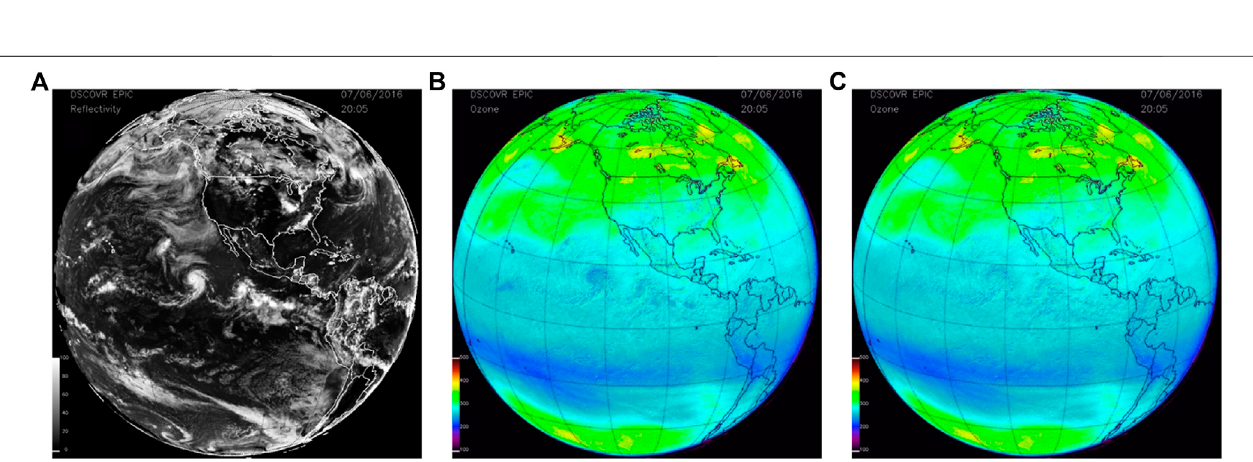
FIGURE 2 | EPIC synoptic maps of re fl ectivity derived from 380 nm channel (A) and EPIC retrieved TOZ processed using OPT climatology (B) and simultaneous A-Band cloud height (C) . The cyclonic activity in the tropical Paci fi c area west from Central America is clearly seen in the re fl ectivity map (A) . The TOZ map derived with climatologicalcloudheights (B) hasarti fi cialstructuresthatareco-locatedwiththecyclones.WhenthesimultaneouscloudheightproductfromEPICisusedintheozone algorithm (C) it reduces arti fi cial structures in the derived synoptic TOZ maps.